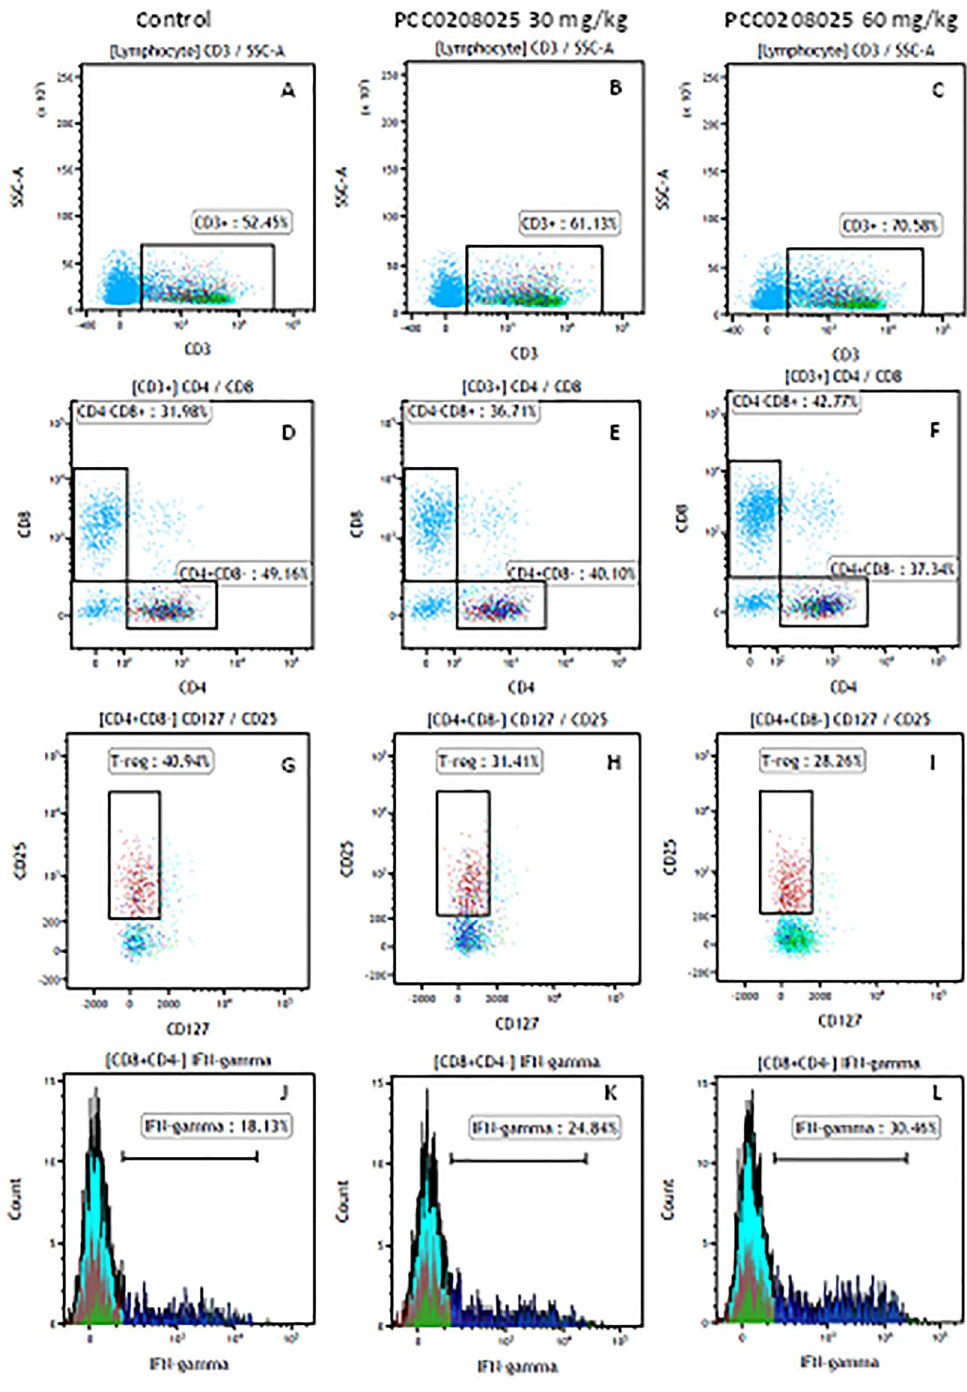
Fig 6. The representative figures for T cell subsets counted by flow cytometry from tumors in B16-F10-bearing mice. The cell counts for CD3 + (A, B and C), CD3 + CD4 + (D, E and F), CD3 + CD8 + (D, E and F), CD4 + CD25 + CD127 low/- (G, H and I) and CD8 + IFN- γ + (J, K and L) T lymphocytes from mouse tumor were determined by flow cytometry.